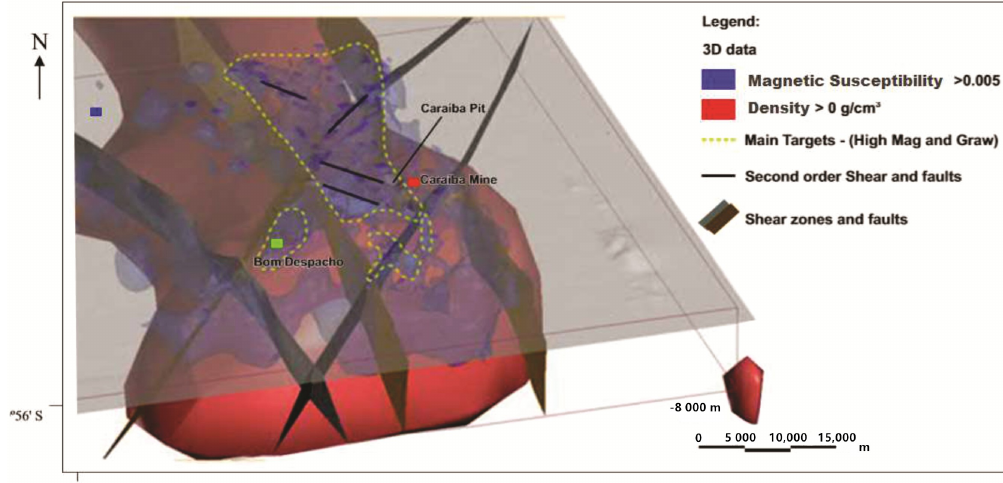
Figure 9. Draping structure and MVI magnetic (SI > 0.005) and density contrast ( > 0 g / cm 3 ) inversion onto the terrain surface surrounding the Cara í ba mine (Curaç á copper district). In the Vale do Curaç á district, a series of subparallel N–S magnetic trends were found. A great number of magnetic anomalies are related to geological units represented by mafic granulites and granulitic orthogneiss. The dashed yellow area denotes the main target with high potential to host new IOCG orebodies in the Vale do Curaça